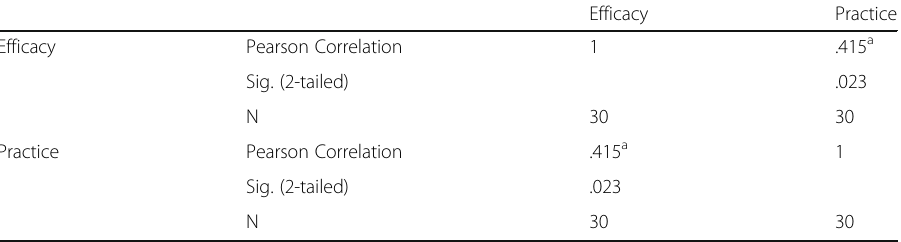
Table 8 Pearson Correlation Results for Hard Discipline Teachers ’ Self-efficacy and Instructional